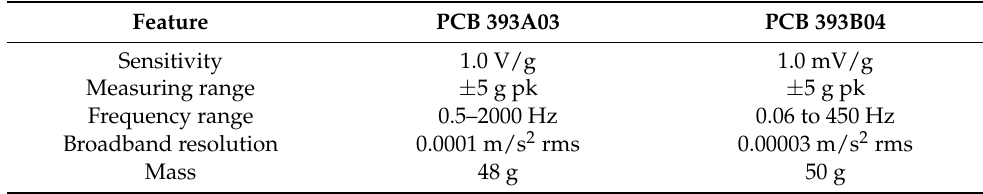
Table 2. Equipment characteristics.